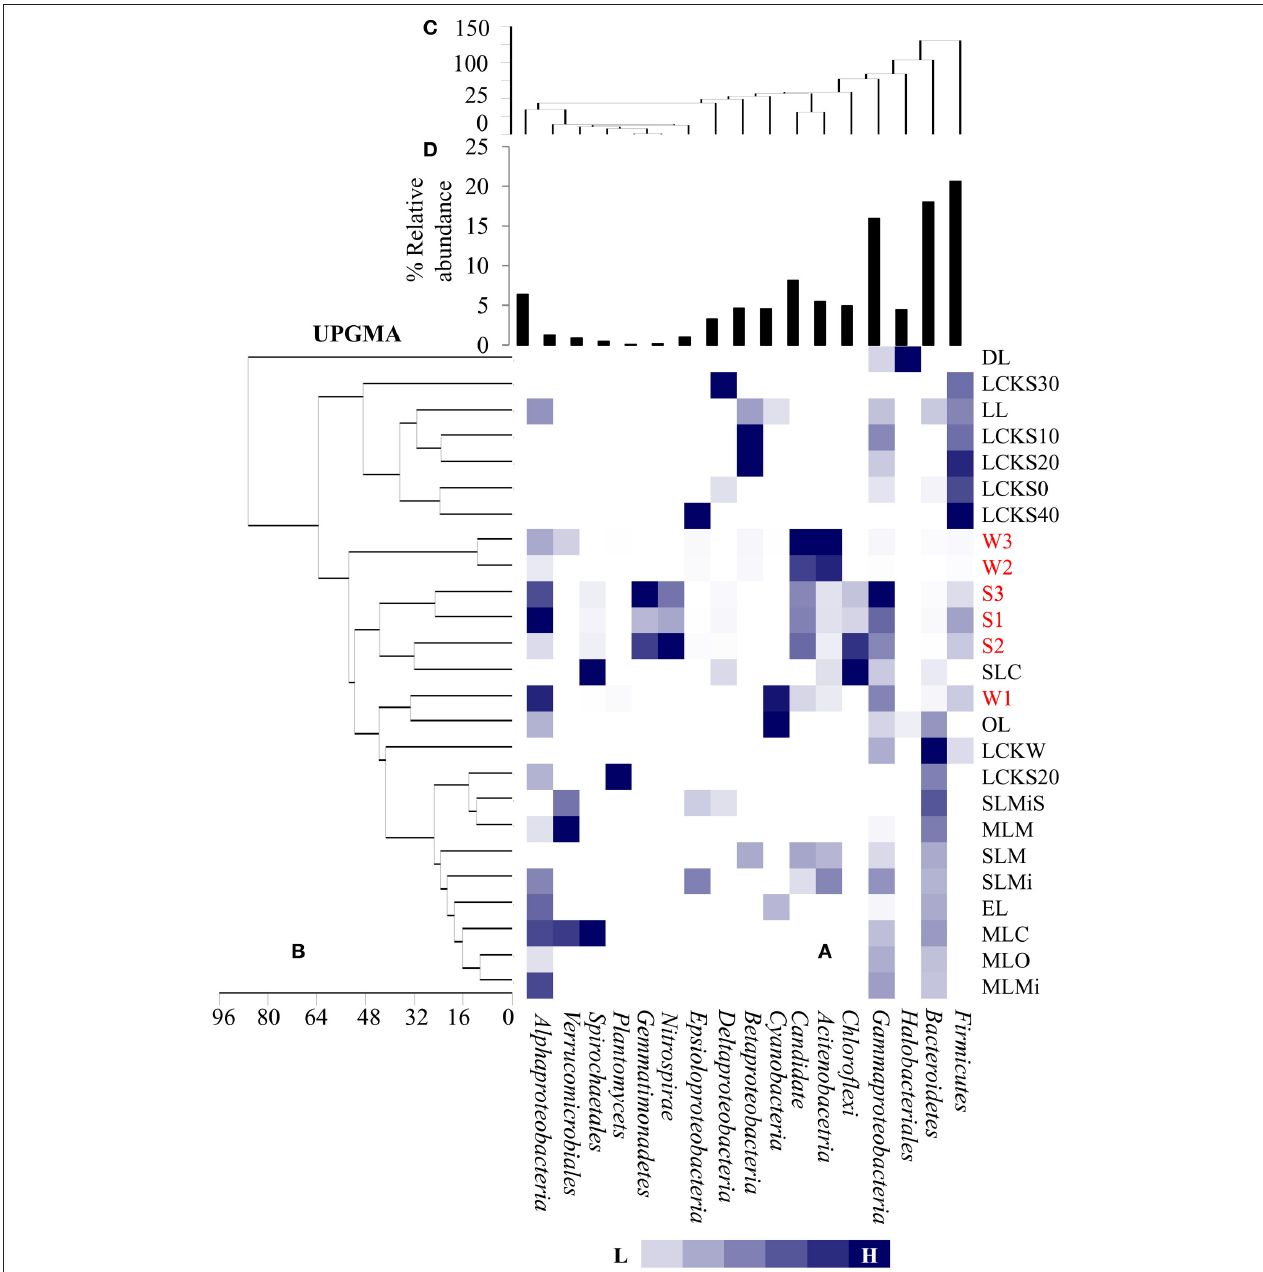
FIGURE 5 | Comparative analysis of bacterial community composition (A) among the present samples as well as those reported earlier from diverse hypersaline lake ecosystem, (B) UPGMA cluster analysis among the samples based on abundance of different bacterial groups as detected in different lake system, (C) UPGMA cluster analysis among the bacterial groups detected in diverse lake system and (D) relative abundance of the bacterial phylum. The samples are denoted as follows: DL, Deep Lake (Colorado); LCKS30, Lake Chaka (China); LL, Lonar Lake (India); LCKS10, Lake Chaka (China); LCKS20, Lake Chaka (China); LCKS0, Lake Chaka (China); LCKS40, Lake Chaka (China); W3, Lonar Lake water (present study); W2, Lonar Lake water (present study); S3, Lonar Lake sediment (present study); S1, Lonar Lake sediment (present study); S2, Lonar Lake sediment (present study); SLC, Soap Lake Chemocline (Washington); W1, Lonar Lake water (present study); OL, Organic Lake (Eastern Antarctica); LCKW, Lake Chaka (China); LCKS20, Lake Chaka (China); SLMiS, Soap Lake Mixolimnion sediment (Washington); MLM, Mono Lake Monimolimnion (California); SLM, Soap Lake Monimolimnion (Washington); SLMi, Soap Lake Mixolimnion (Washington); EL, Echo Lake (Colorado); MLC, Mono Lake Chemocline (California); MLO, Mono Lake Oxycline (California); MLMi, Mono Lake Mixolimnion (California). The details of these samples are provided as Supplementary Information ( Table S2 ).